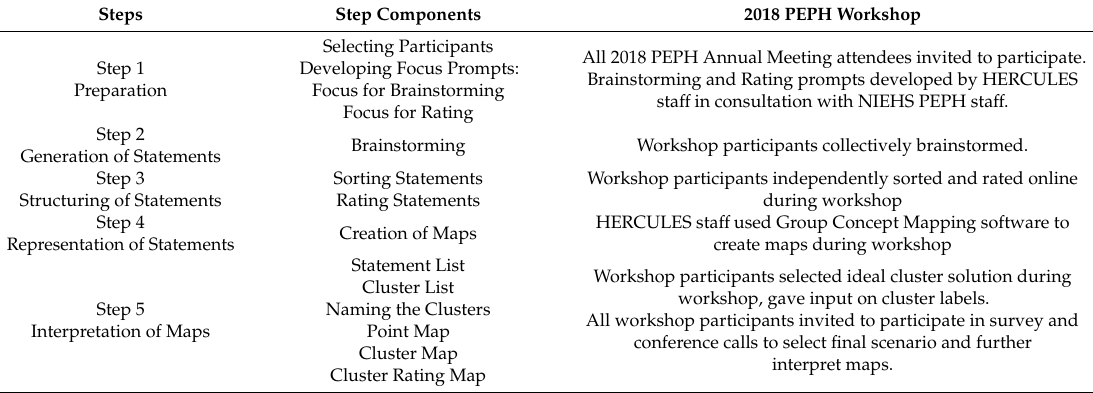
Table 1. Concept Mapping Steps and their Application with the Partnerships for Environmental Public Health (PEPH)